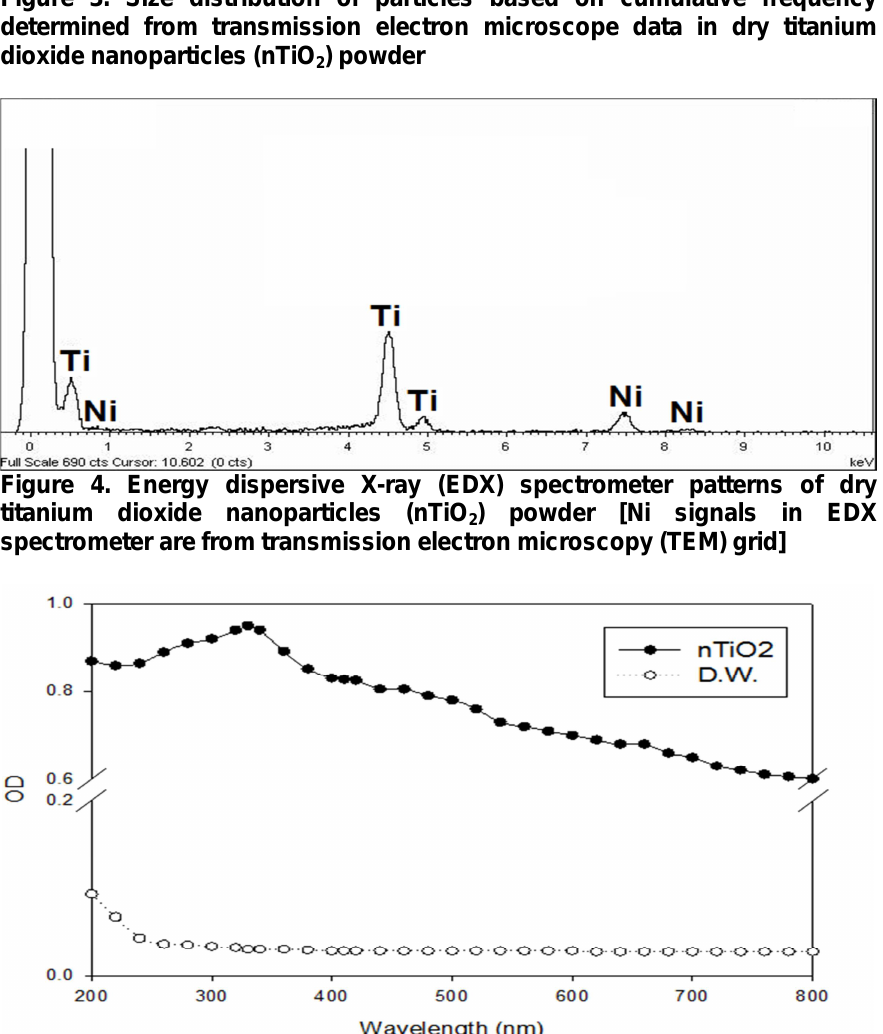
Figure 5. UV–VIS absorption spectra of suspensions of titanium dioxide nanoparticles (nTiO2) and distilled water